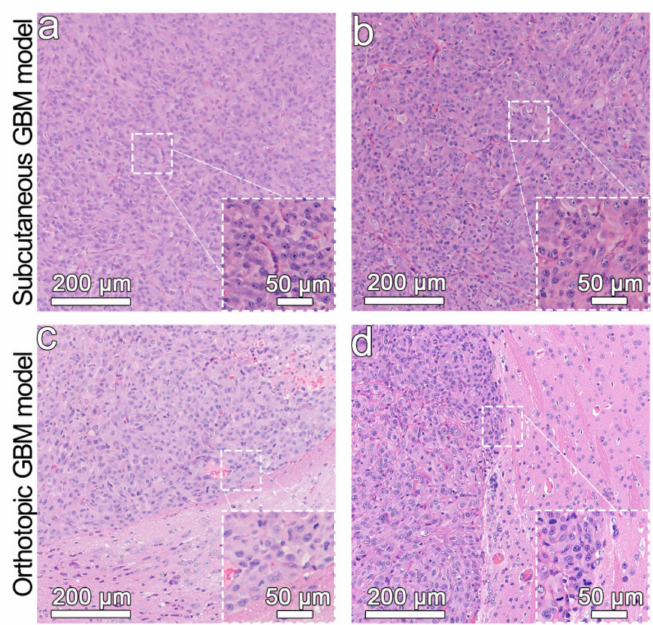
Figure 4. H&E staining of the subcutaneous glioblastoma model ( a , b ) and the orthotopic glioblastoma model ( c , d ). The inserts illustrate the high magnification